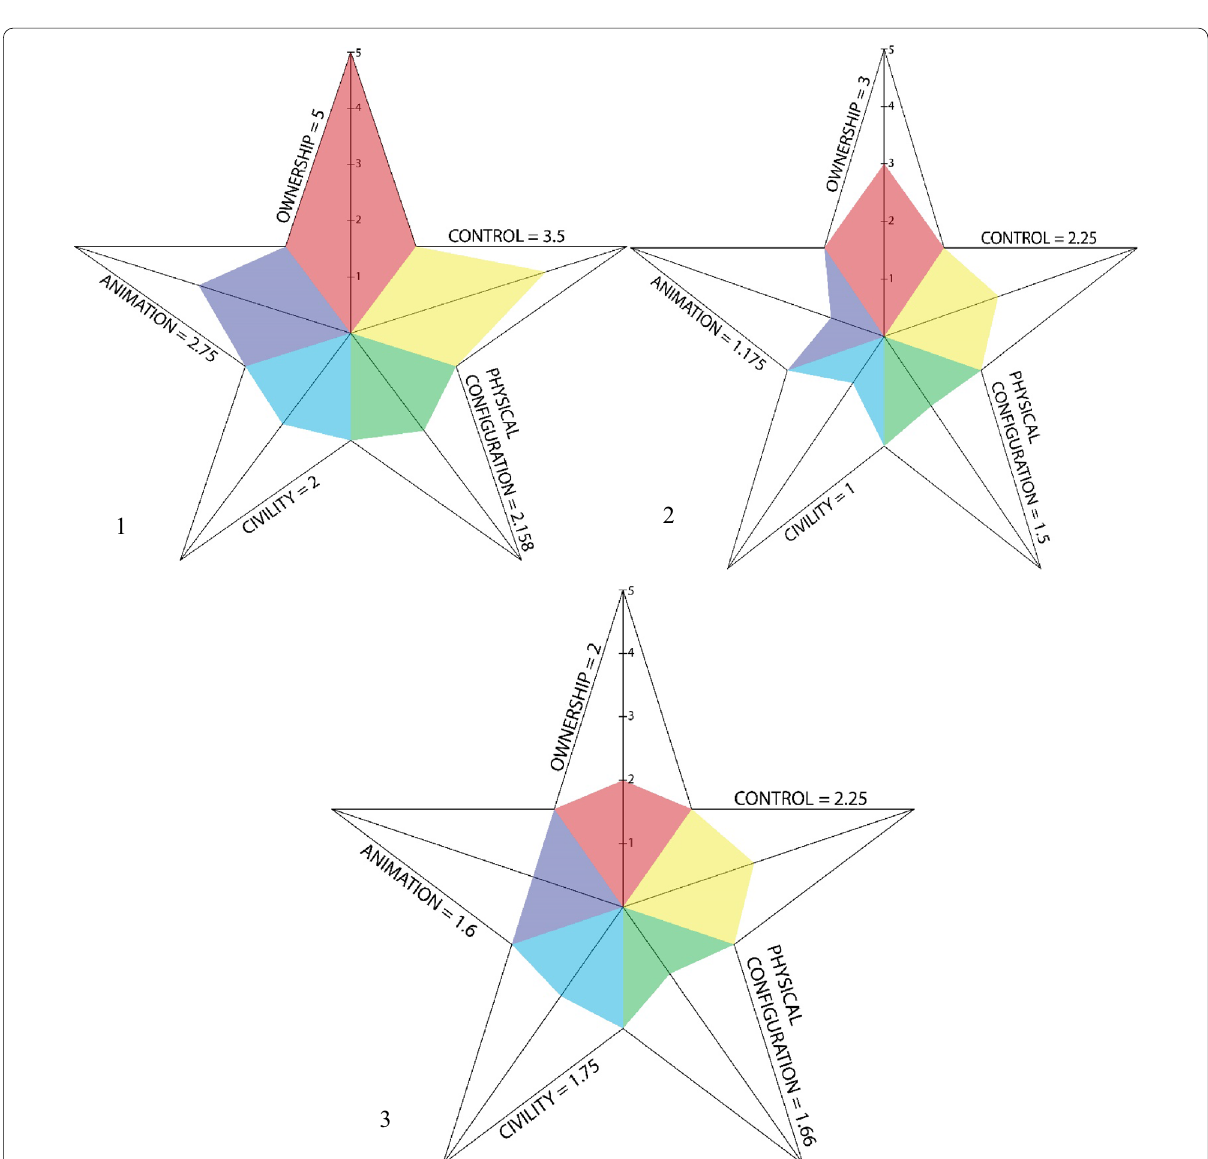
Fig. 4 Star model representation of the level of publicness ( 1—Wisdom Park, 2—Minister Meda, and 3—Agoza Meda )